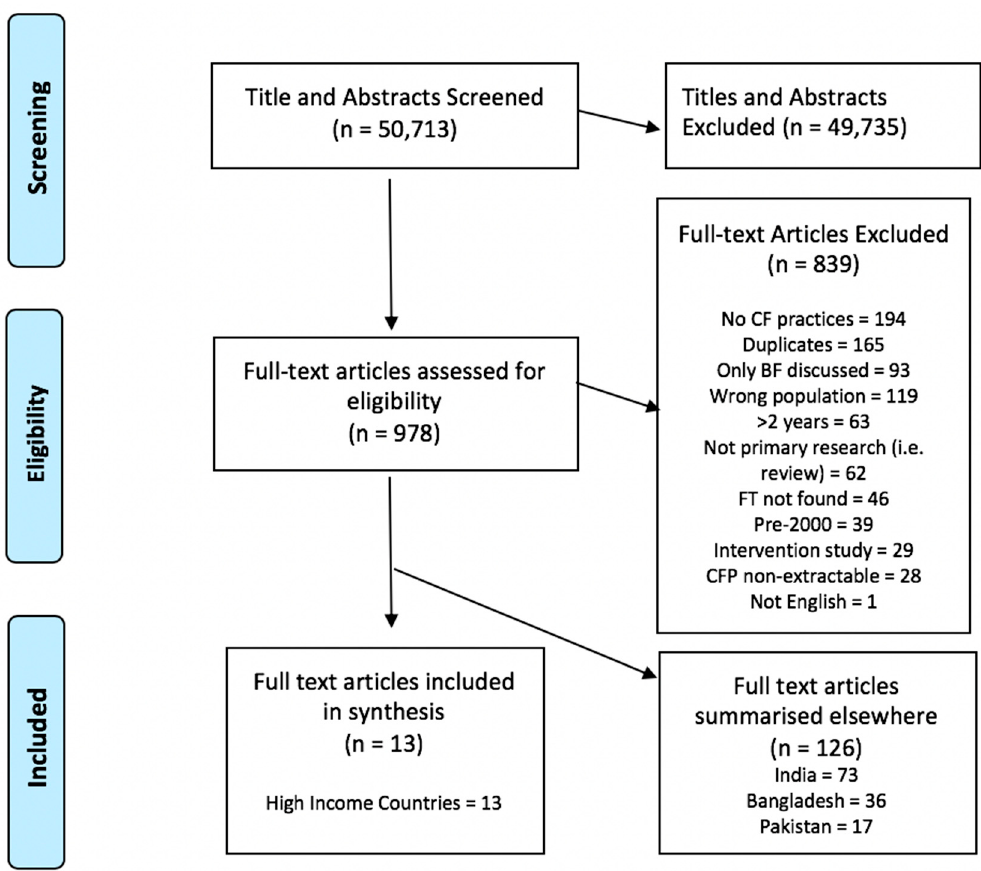
Figure 1. Preferred Reporting Items for Systematic Reviews and Meta-Analyses (PRISMA) flow diagram—study selection process. CF, complementary feeding; CFP, complementary feeding practices; BF, breastfeeding; FT, full text.